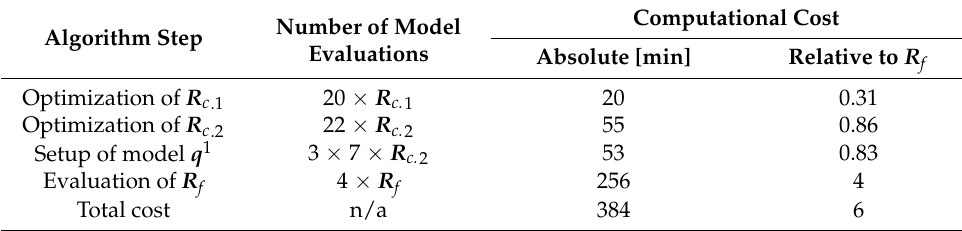
Table 6. On-chip inductor optimization cost.